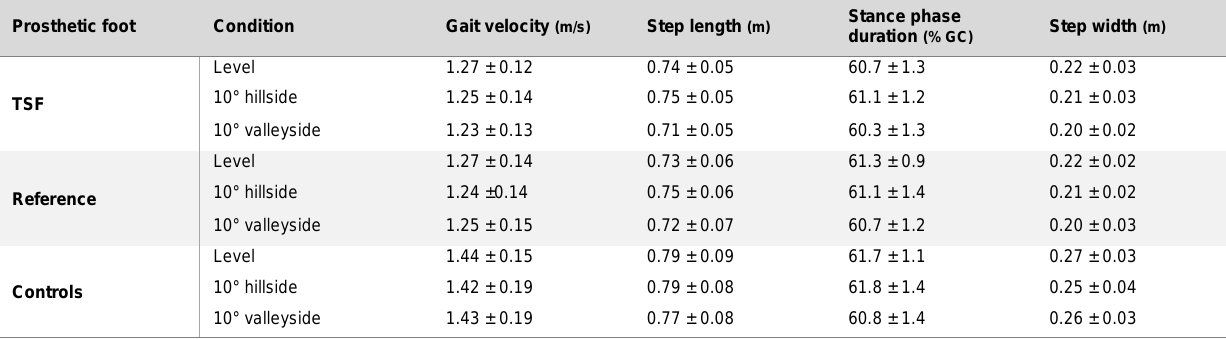
Table 2: Spatiotemporal parameters of the TSF and reference feet for level walking and 10° cross-slope conditions. No statistically significant differences between foot types were found (p<0.01)